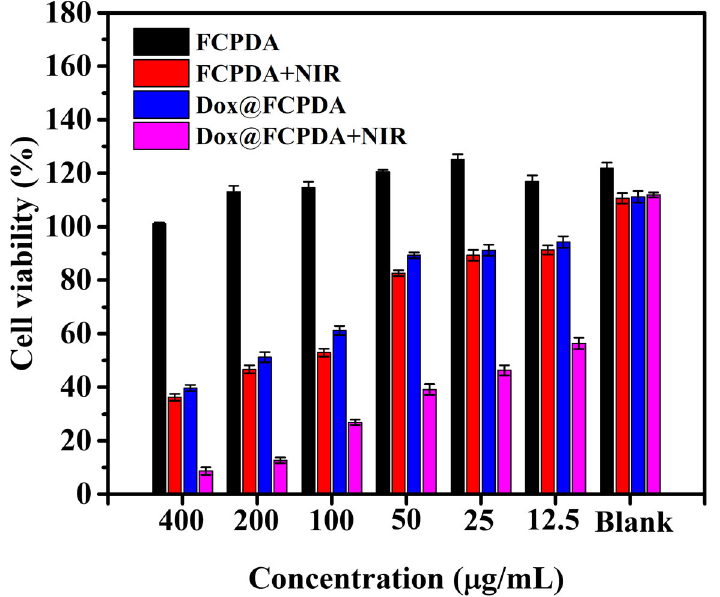
Figure 8. In vitro cytotoxicity of HepG2 cancer cells treated with various concentrations (400–12.5 µg/mL) of FCPDA and Dox@FCPDA nanoparticles with and without NIR laser treatment (808 nm, 2 W/cm 2 , and 10 min).